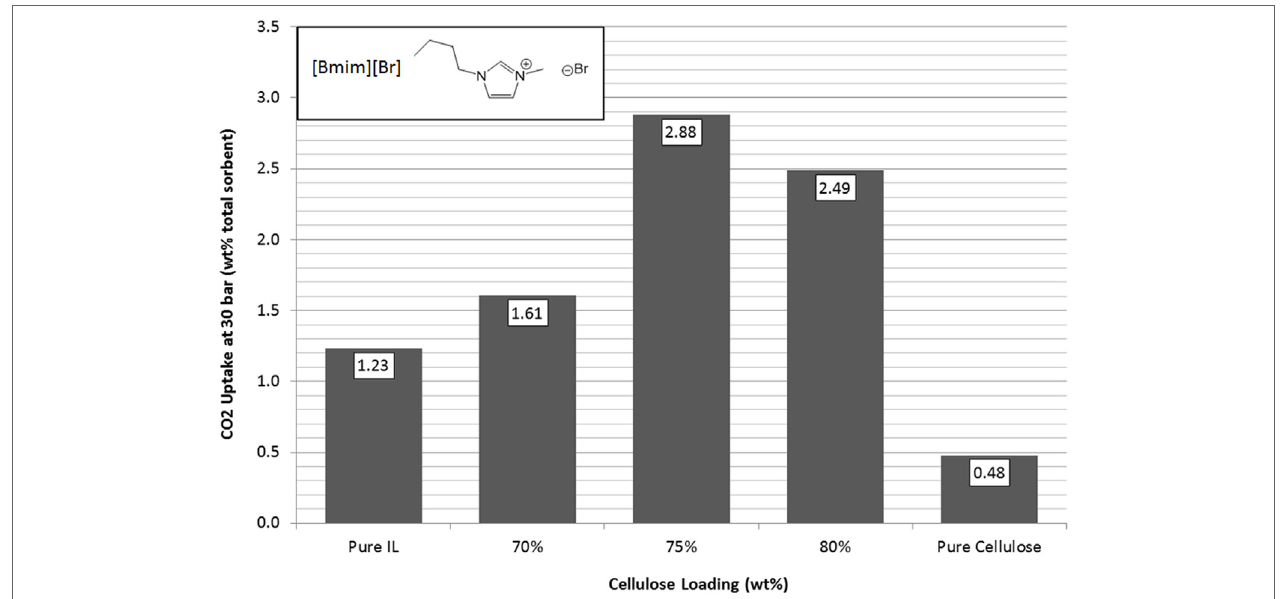
FigUre 8 | Trends in total sorbent CO 2 uptake at 30 bar for [Bmim][Br] as a function of cellulose loading at room temperature.